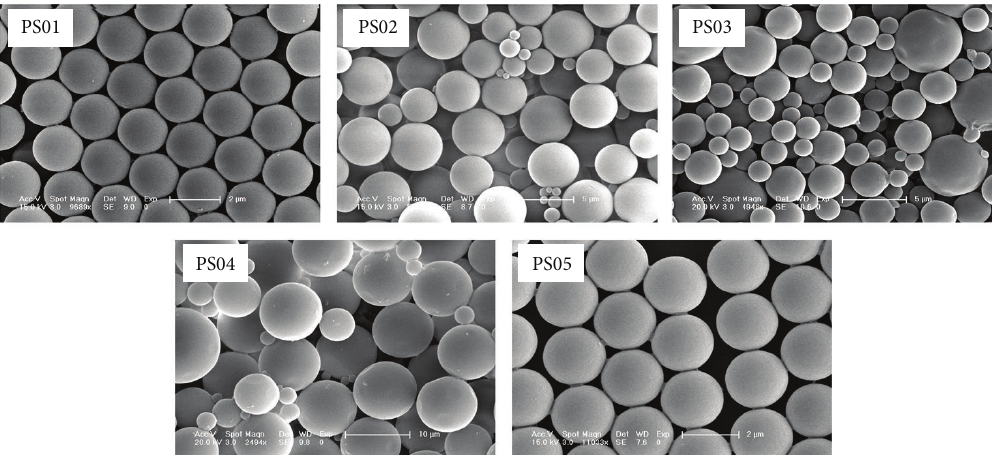
Figure 1: SEM images of polystyrene microspheres synthesized with different dosages of ethanol.